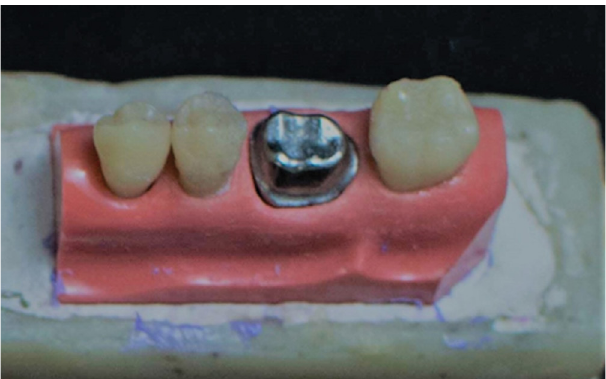
Figure 1. The metal die (copy of the mandibular left first molar prepared for a complete metaloceramic crown) adapted to the left mandibular hemi-arch.